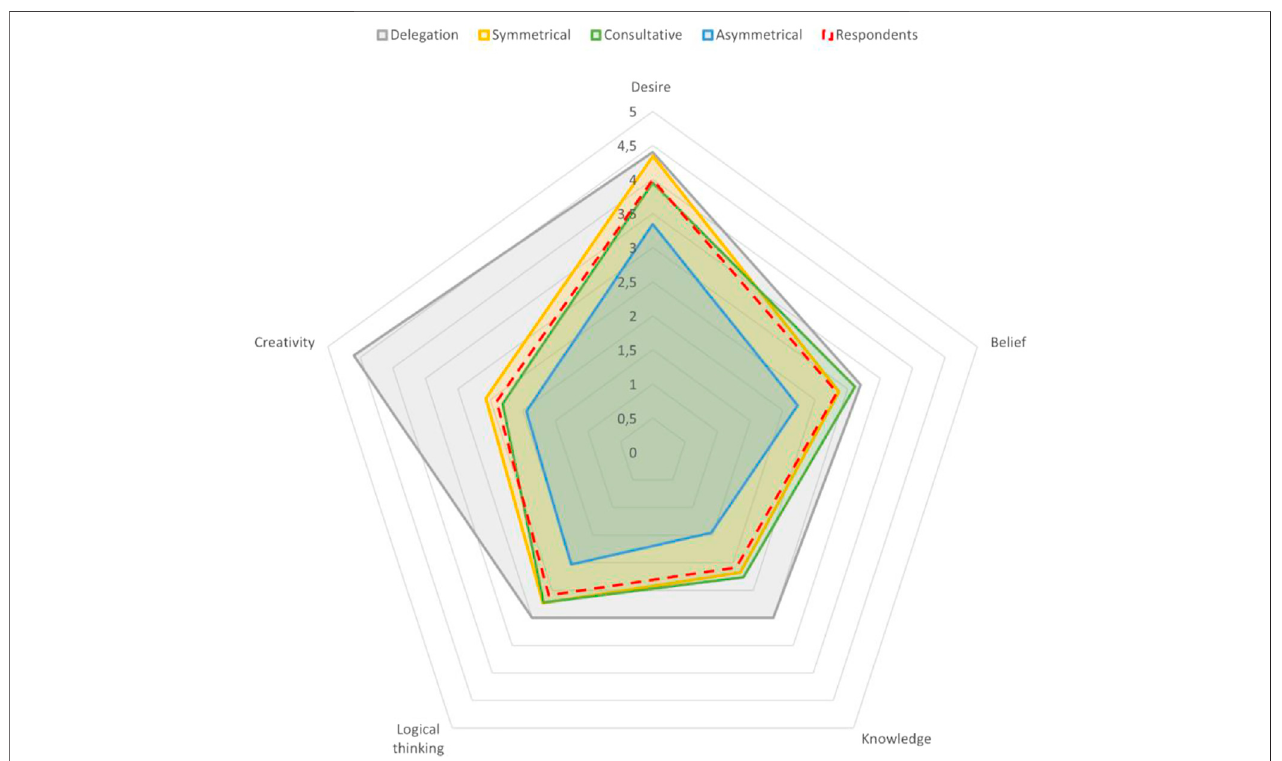
FIGURE 4 | The range of features characteristic for each participation model and model representing respondents. Presented features are: (i) desire to rest at the lake, (ii) belief in the effectiveness of actions taken by municipal authorities, (iii) knowledge, (iv) logical thinking, and (v) creativity.